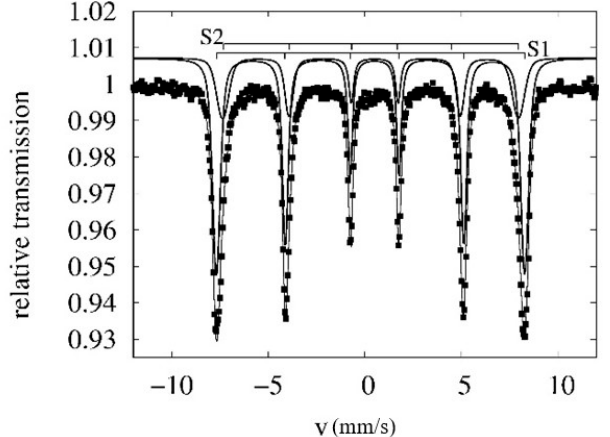
Figure 12. RT Mössbauer spectrum of the EC solid product prepared from leachate of EAFS*.